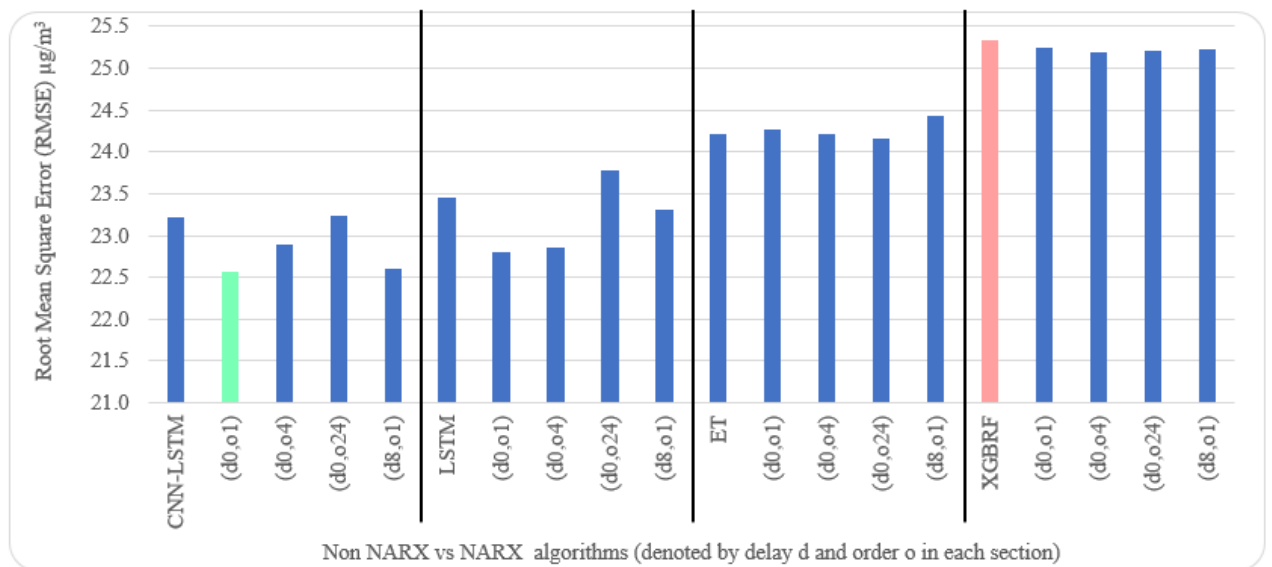
Figure 24. Evaluation results of non-NARX and NARX in terms of root mean square error for the Beijing dataset.